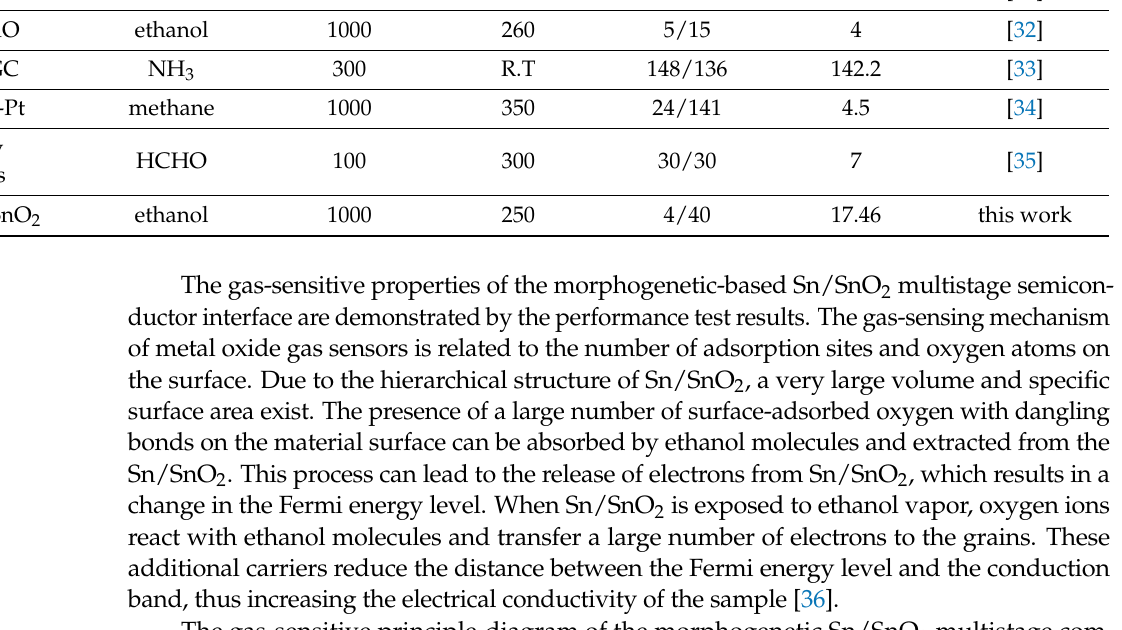
Table 1. Gas-sensing performance toward different gases reported in this work and in the litera- ture.